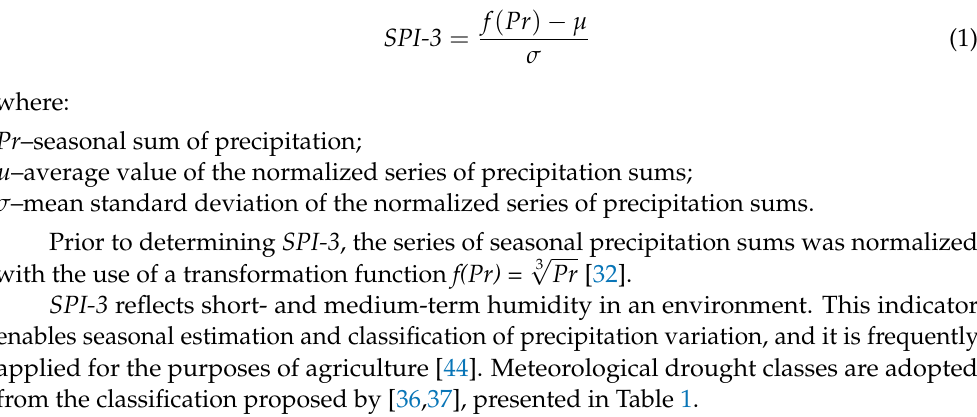
Table 1. Classes of meteorological drought according to the SPI-3 index. Class Symbol SPI-3 Extreme drought Ed ≤− 2.0 Severe drought Vd [ − 1.5; − 2.0) Moderate drought Md [ − 1.0; −